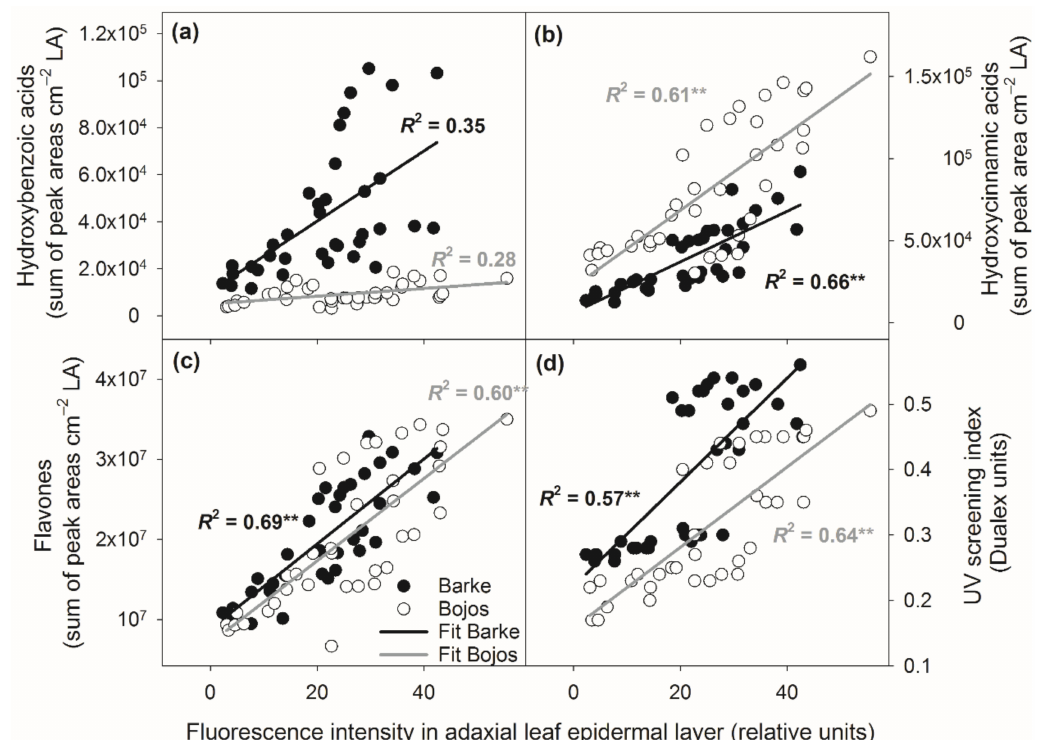
Figure 9. Linear relationships between accumulation of different groups of PhCs in adaxial leaf epidermal layer measured as fluorescence intensity under blue light excitation and total amount of ( a ) hydroxybenzoic acids, ( b ) hydroxycinnamic acids, ( c ) flavones, and ( d ) UV screening index. Amounts of hydroxybenzoic acids, hydroxycinnamic acids, and flavones are expressed per unit leaf area (LA). Relationships are separated by barley ( Hordeum vulgare) variety: Barke–black points and black lines, Bojos–empty points and grey lines. The index of determination ( R 2 ) and significance of Pearson’s correlation coefficient (** significant at p =